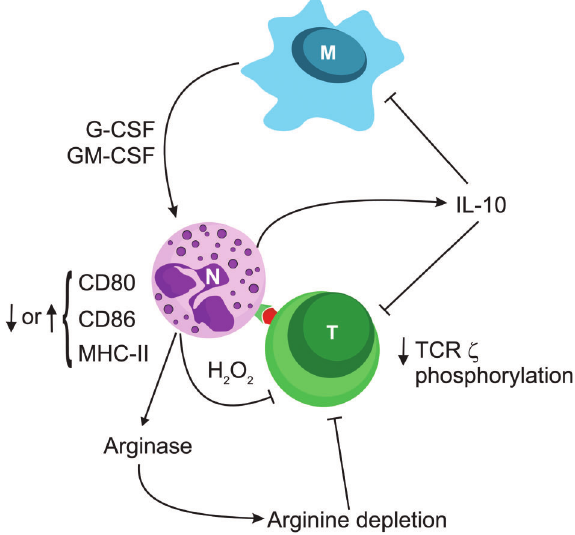
Figure 2. Neutrophils (N) cross-talk with other immune cells and are receptive of various innate or adaptive immunity system stimuli. This fi gure illustrates an example of the numerous possibilities for reciprocal regulation. Macrophages (M), along with many other cytokines, produce granulocyte colony-stimulating factor (G-CSF) and granulocyte-macrophage colony-stimulating factor (GM-CSF), which can in turn induce production of cytokines such as interleukin (IL)-10 by neutrophils. Under different condi- tions, neutrophils can modify the extent of major histocompatibility complex (MHC) and costimulatory molecule expression, produce reactive oxygen species and nitric oxide synthase, or consume arginine leading to inhibition of the T-cell (T) response. TCR: T-cell